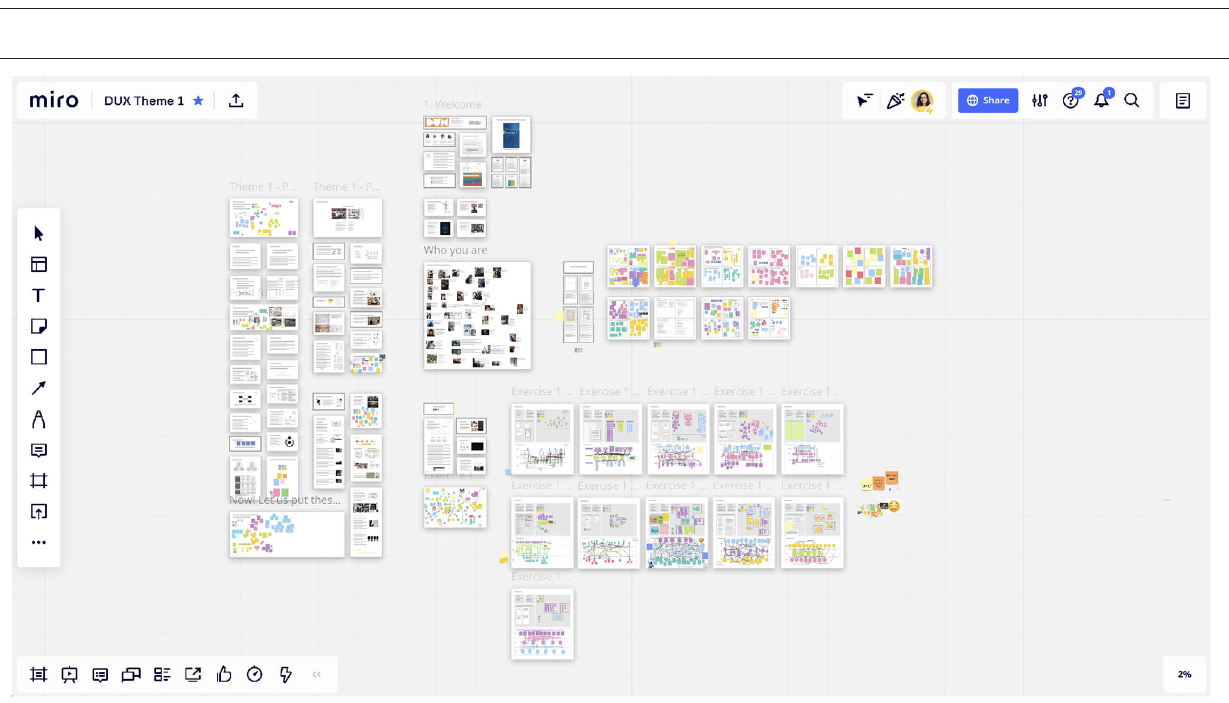
FIGURE 5 | Screenshot of a populated Miro board after the week in the course. Most of what is seen was added by the students. The aim of this figure is not for the content to be readable, but rather to show the structure and general feeling of an empty board, particularly when compared to when the board is empty as seen in Figure 4